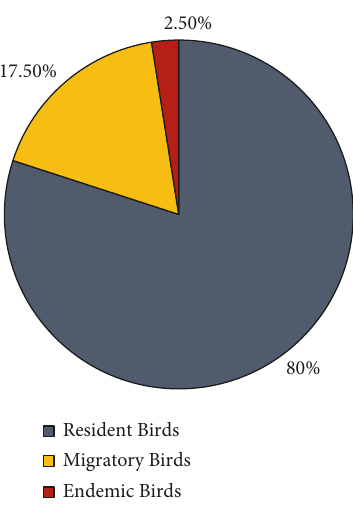
Figure 2: Percentage of resident, migratory, and endemic birds recorded in the